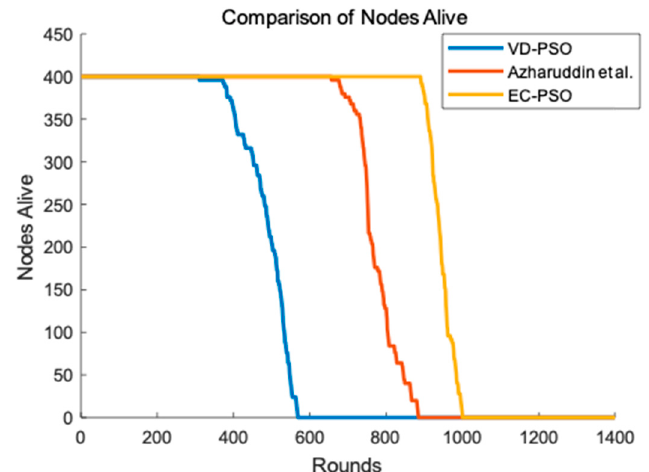
Figure 9. Network lifetime. VD-PSO: Variable Dimension based Particle Swarm Optimization; EC-PSO: Energy Centers Searching using Particle Swarm Optimization.